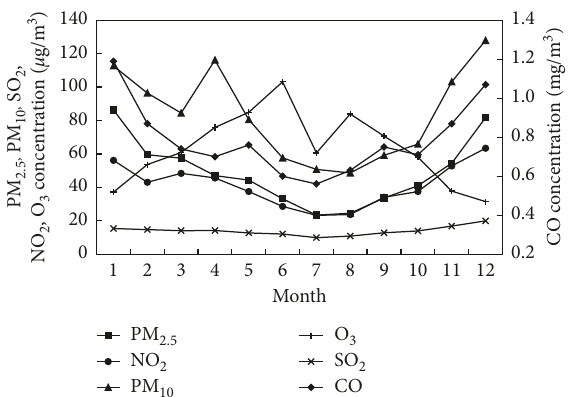
Figure 9: Monthly concentration values of primary air pollutants in Jiangsu Province between September 2017 and August 2018. Unit: PM 2.5 , PM 10 , SO 2 , NO 2 , and O 3 : μ g/m 3 ; CO: mg/m 3